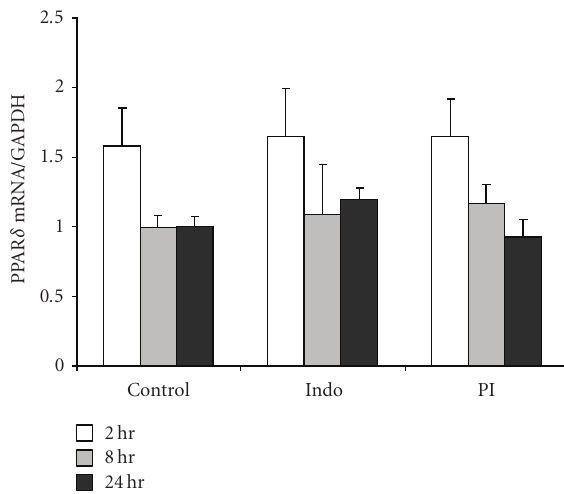
Figure 4: PGE 2 does not a ff ect PPAR δ mRNA expression. RNA was isolated from IMCD-K2 cells using the TRIzol method. The cells had been treated for 2, 8, and 24 hours with serum-free media (control), 10 − 5 M indomethacin (Indo), or 10 − 6 M PGE 2 in the presence of 10 − 5 M indomethacin (PI). The RNA samples were quantified using real-time PCR using primers and probes for PPAR δ . Glyceraldehyde-3-phosphate dehydrogenase (GAPDH) was used as an internal control. Expression is presented as the amount of PPAR δ mRNA expression divided by GAPDH expression. Values are means ± S.E.M.; n = 5.